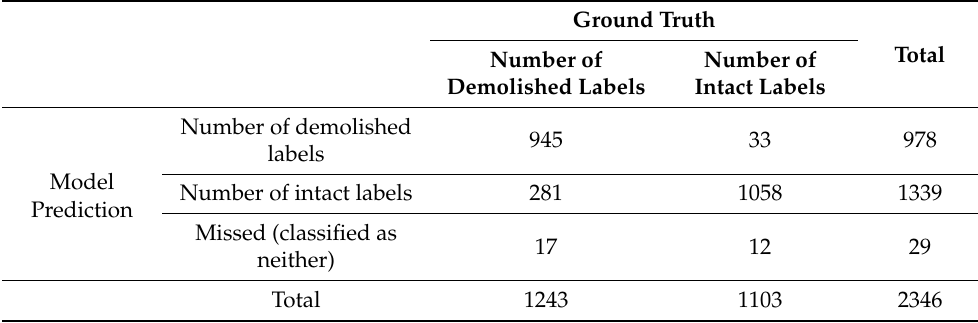
Figure 6. Redefining the accuracy measurement of the network: ( a ) ground truth of a demolished building; ( b ) network probability prediction. Pixel-wise, only 57% are correctly classified, but label- wise and according to our definition, the network has correctly classified this as one instance of a demolished building label (one true positive). Table 1. Confusion matrix against the labels in xView testing dataset using the 30% areal percent- age threshold.